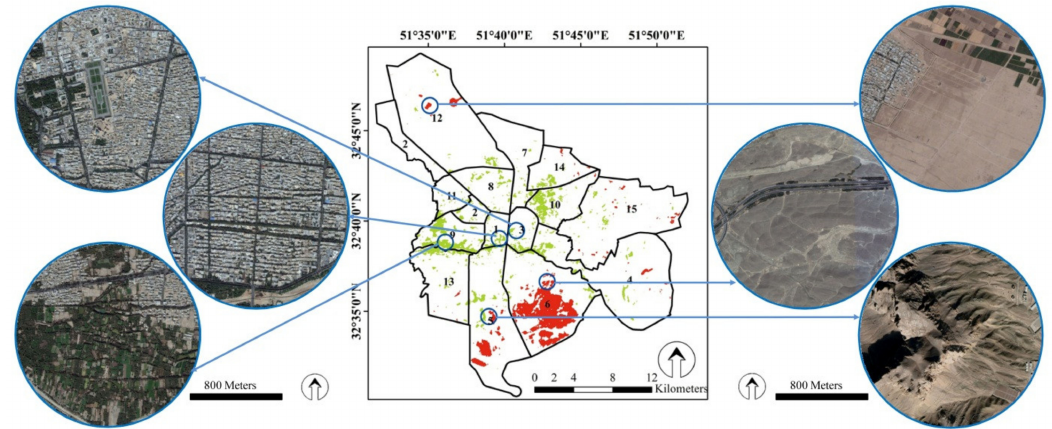
Figure 5. Map of heat and cold islands in Isfahan metropolis and zoomed examples by Google Earth images.